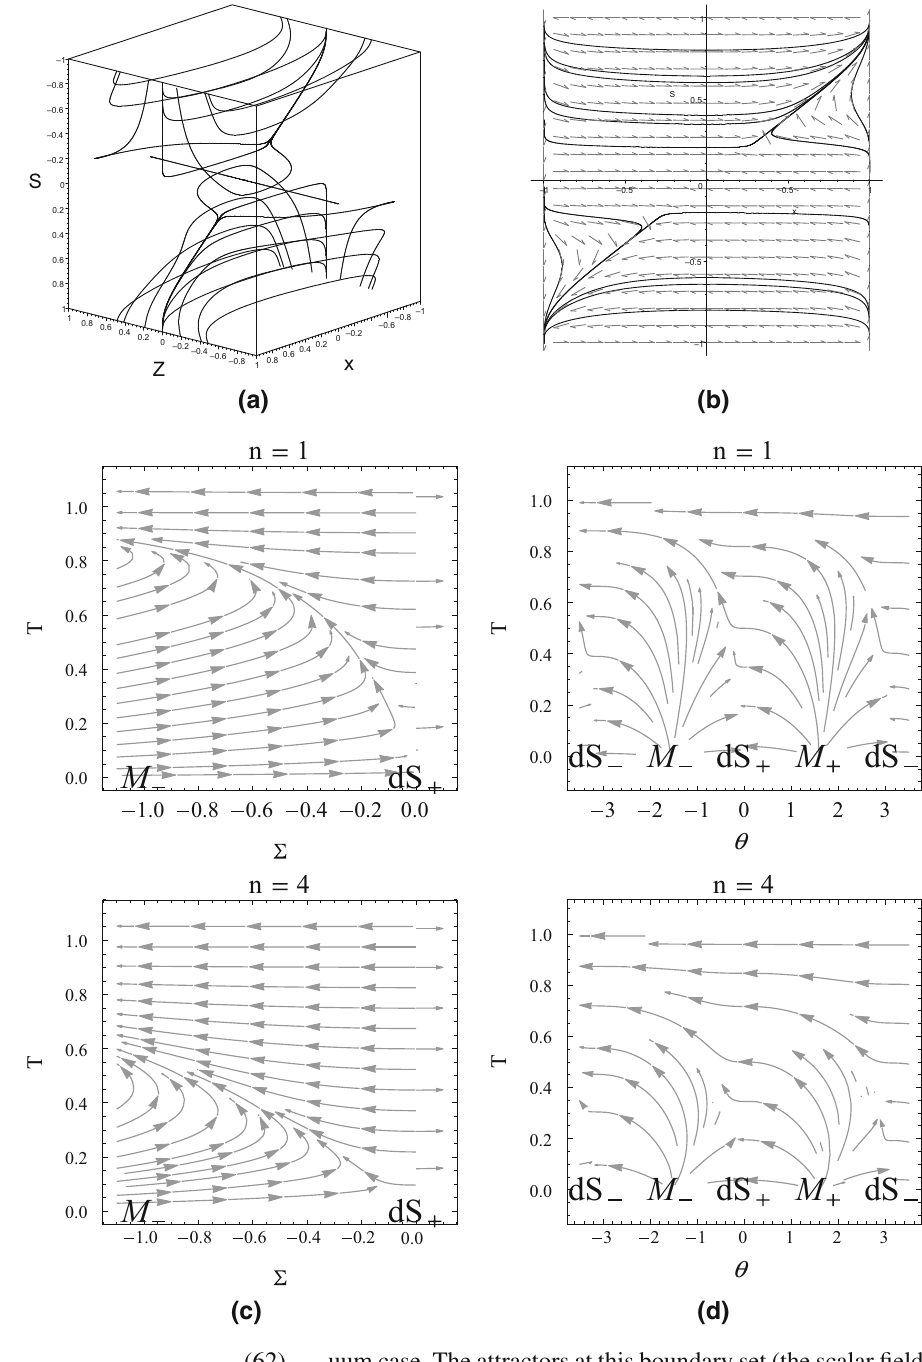
Fig. 2 a Compact phase portrait of (32), (33), (34) for the choice n = 2. b Dynamics in the invariant set Z = 0. c Compact phase portrait of (54) and (56) for − 1 < Y < 0. d Unwrapped solution space for the system (60), (61) for n = 1 ,